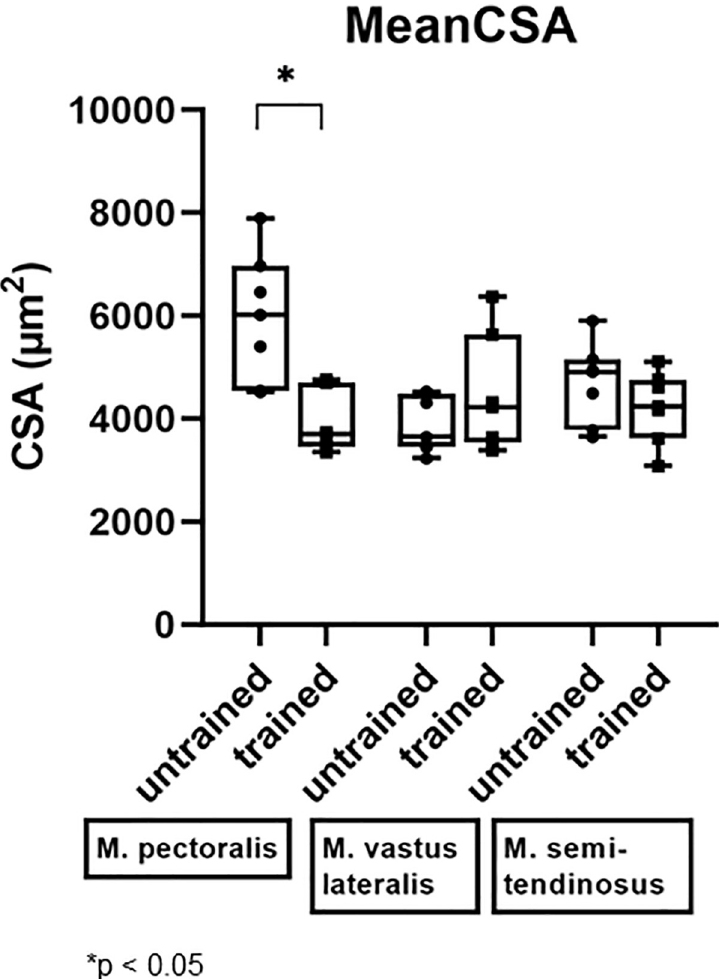
Fig 9. Effect of dry treadmill training on mean cross sectional area (CSA). Effect of 8 weeks of DT on mean CSA was measured in the M. pectoralis, M. vastus lateralis and M. semitendinosus at rest in unconditioned state (untrained) and after 8 weeks of DT (trained) in seven Friesian